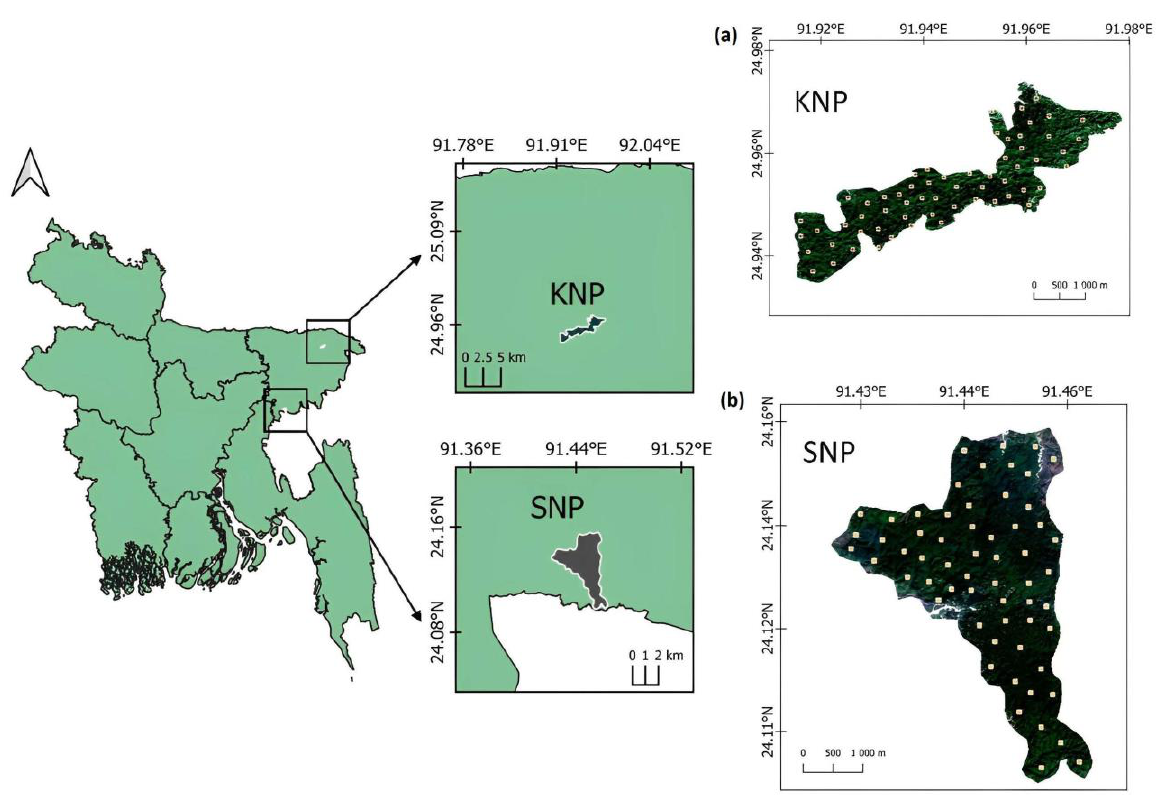
Figure 1. Location map of two studied protected areas ( a ) Khadimnagar National Park (KNP) and ( b ) Satchari National Park (SNP) in Northeast Bangladesh. The yellow dots indicate the plot location within each of the study areas.